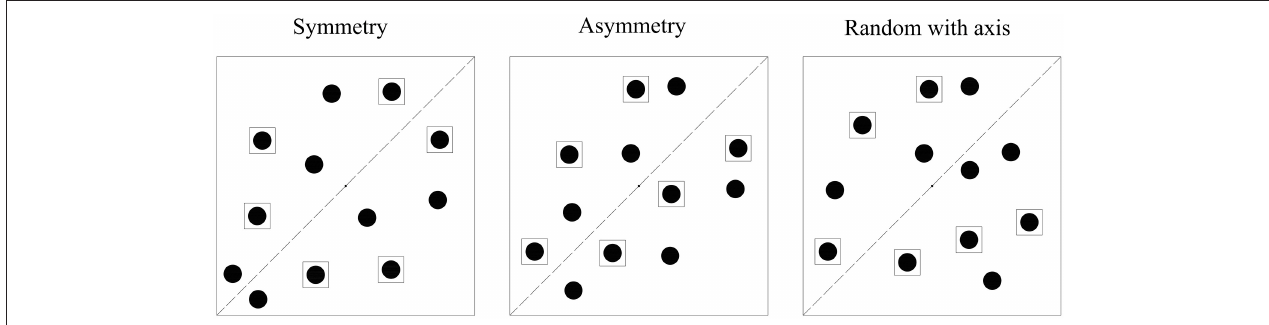
FIGURE 4 | Three target position conditions in Experiment 2: Symmetry, Asymmetry, and Random with axis. Disks inside the black squares were targets.